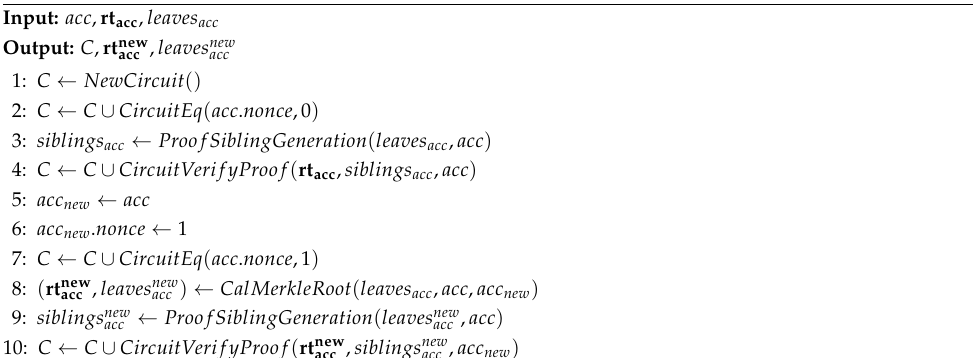
Algorithm 3 Build Access Merkle